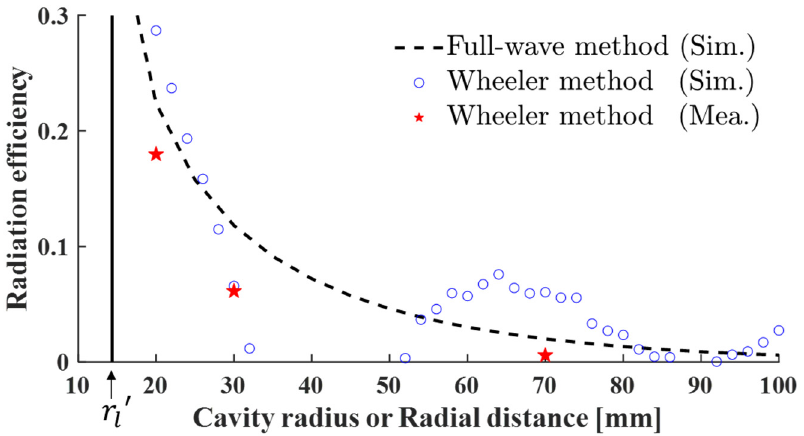
Figure 9. The measured and simulation radiation efficiency η MR versus cavity radius r w and simulation η MR versus radial distance d r . The radian length r l (cid:48) is marked with black lines. The efficiency values measured with a radiation shield having a radius (20 mm) close to the radian length r l (cid:48) (14.4 mm) is compared with the simulated values in Figure 10. The calculated error from 300 to 600 MHz is less than 3%.